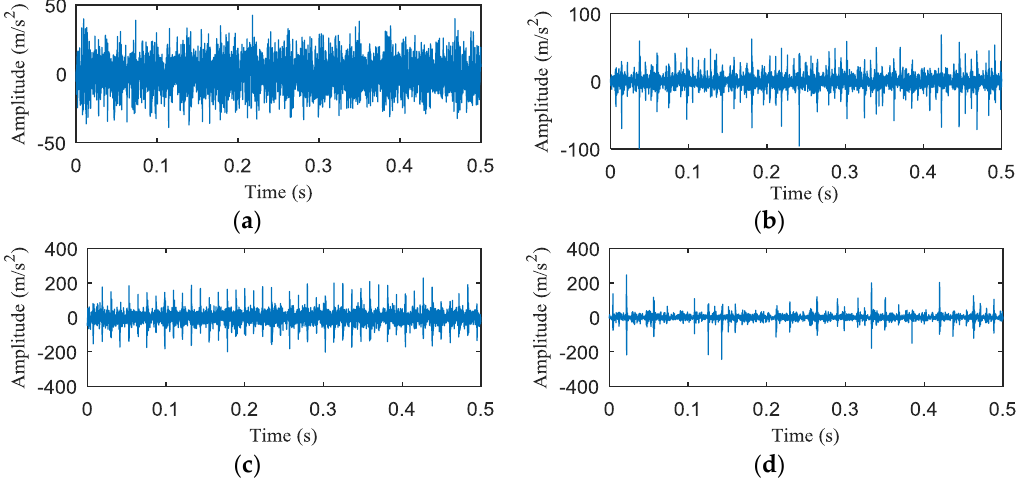
Figure 8. The waveform of ( a ) the normal; ( b ) inner-race fault; ( c ) outer-race fault; ( d ) rolling element fault.